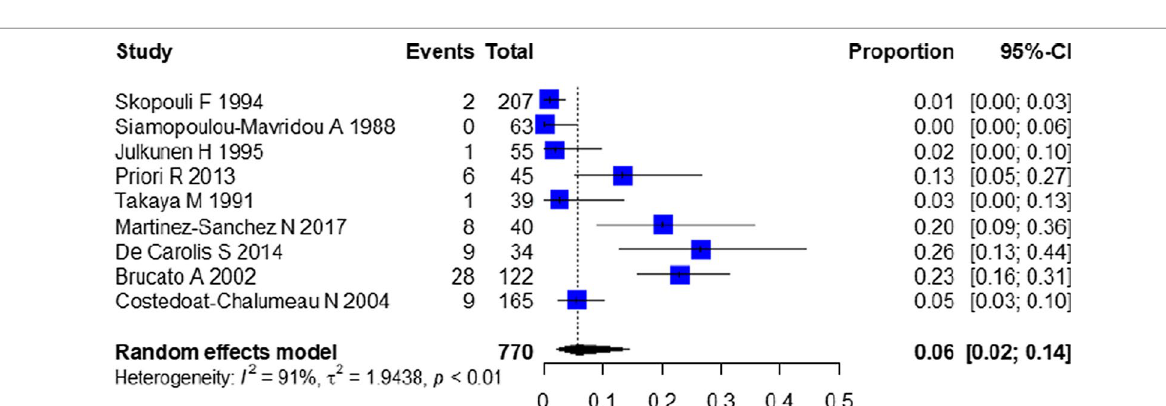
Fig. 8 Meta‑analysis of the incidence of premature delivery in pregnant women with Sjogren’s syndrome or rheumatic diseases with reactive anti‑SSA/Ro